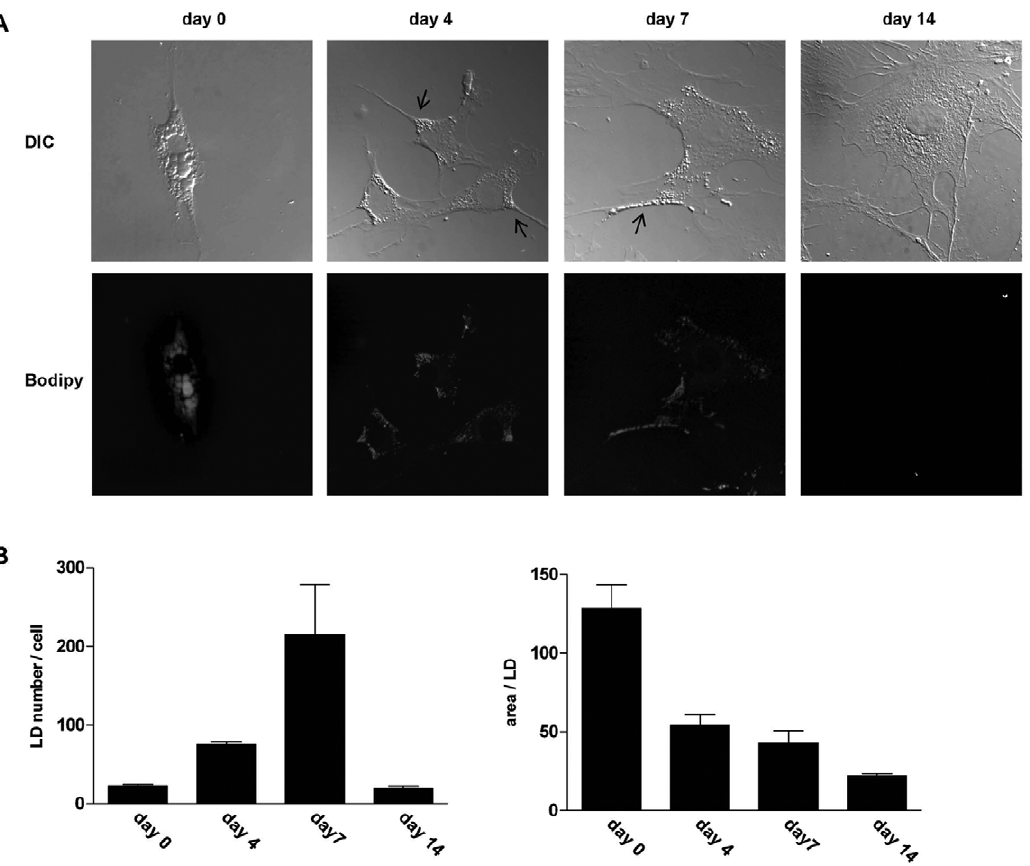
Figure 1. HSC activation results in redistribution of LDs and is accompanied by a decrease in size. A. Freshly isolated HSCs were cultured and fixed after 2 h (day 0), and 4, 7 or 14 days. Morphology and neutral lipid content was analyzed by differential interference contrast microscopy (DIC) and fluorescence microscopy after Bodipy staining of LDs. Arrows indicate LD redistribution. B. Total number of LDs in HSCs at day 0, 4, 7 and 14 and the area per LD was quantified by Image J software. The results represent the means 6 SEM of 10 representative cells.